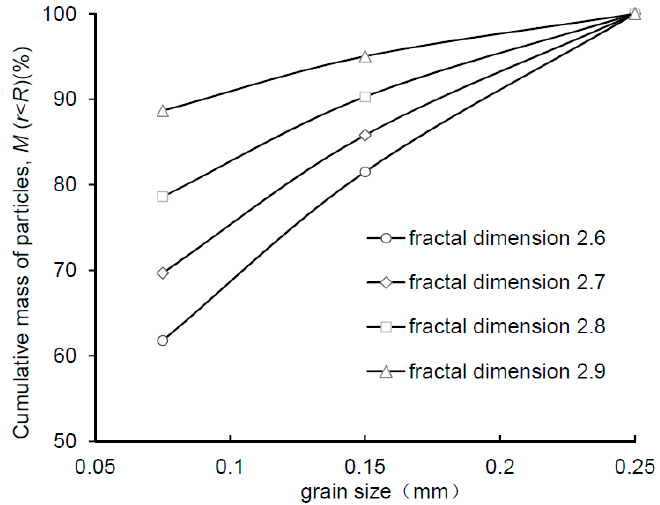
Figure 3. Fractal dimension of particle mass size distribution for artificial specimen G1~G4.